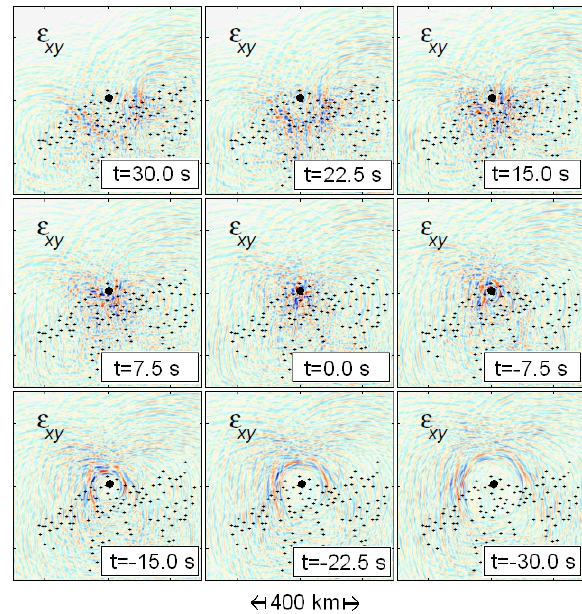
Fig. 11. Source-receiver geometry of the real-data TR experiment for the 2000 Tottori earthquake. Red triangles mark the positions of the 111 stations used in the experiment, and the black star indicates the epicentre as inferred by Semmane (2005). The seismograms shown are vertical component velocities in the chosen frequency band.